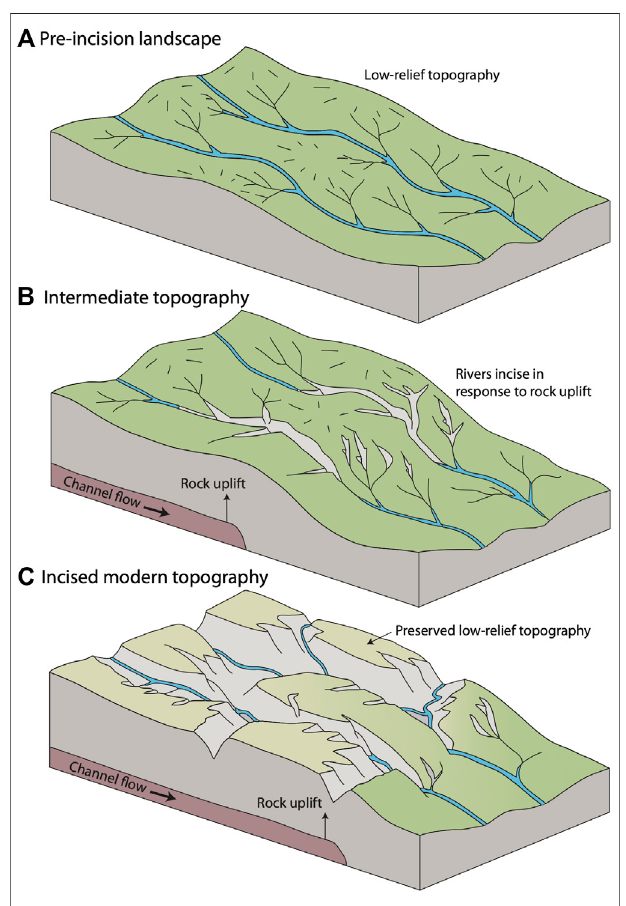
FIGURE 1 | Hypothesis 1. (A) Before the onset of rock uplift across SE Tibet, Hypothesis 1 proposes that there was a low-relief landscape with low erosionrates. (B) Duetolower-crustalchannel fl ow,rockupliftratesincreased and riversincisedintothelow-relief landscape. (C) Remnants ofthelow- relief landscape are preserved today and have not been removed by erosion. Therefore,thelow-reliefremnantscanpotentiallybeusedtomapgeodynamic